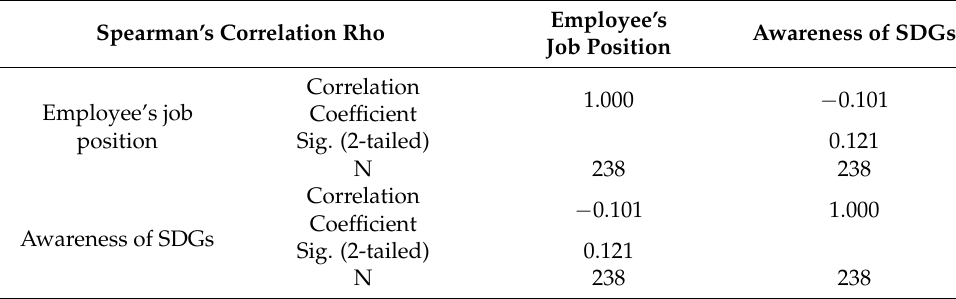
Table 8. Evaluation of RH2 (own elaboration,